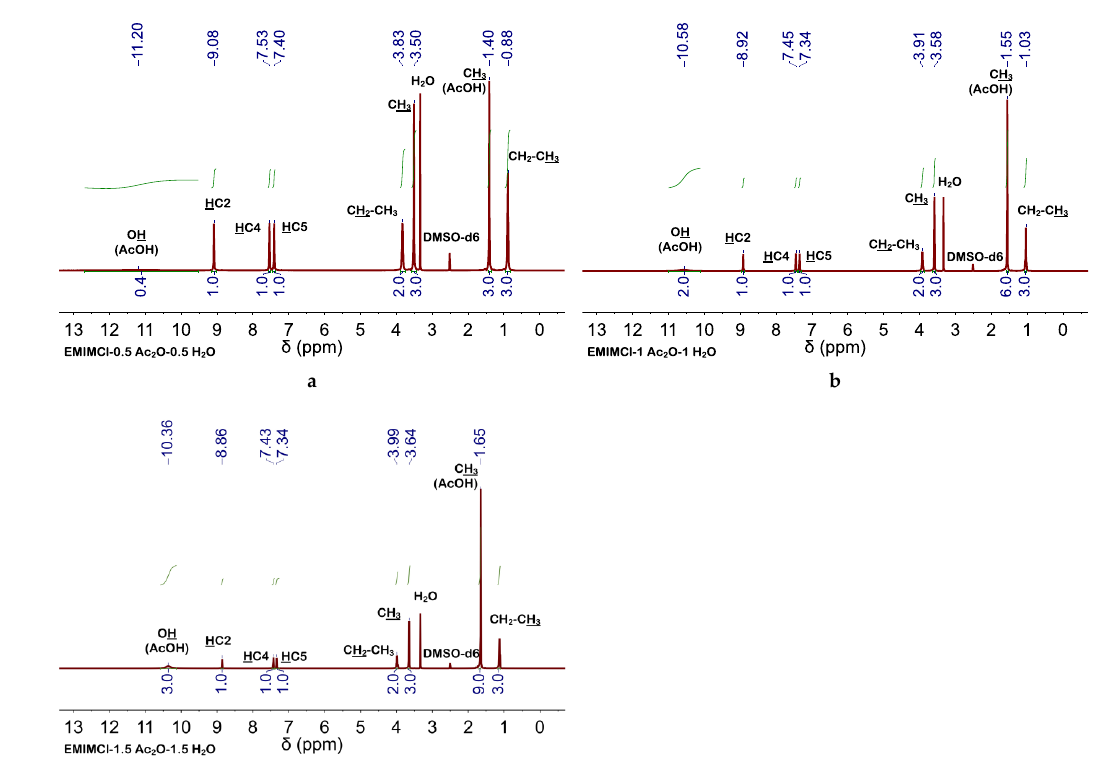
Figure 4. 1 H NMR spectra of EMIMCl · HOAc-based DESs; ( a ) EMIMCl · 1HOAc obtained by addition of 0.5 equivalents of Ac 2 O and 0.5 equivalents of H 2 O to 1 equivalent of EMIMCl, ( b ) EMIMCl · 2HOAc obtained by addition of 1 equivalent of Ac 2 O and 1 equivalent of H 2 O to 1 equivalent of EMIMCl, and ( c ) EMIMCl · 3HOAc obtained by addition of 1.5 equivalents of Ac 2 O and 1.5 equivalents of H 2 O to 1 equivalent of EMIMCl. All 1 H NMR spectra were performed at 25 ◦ C.